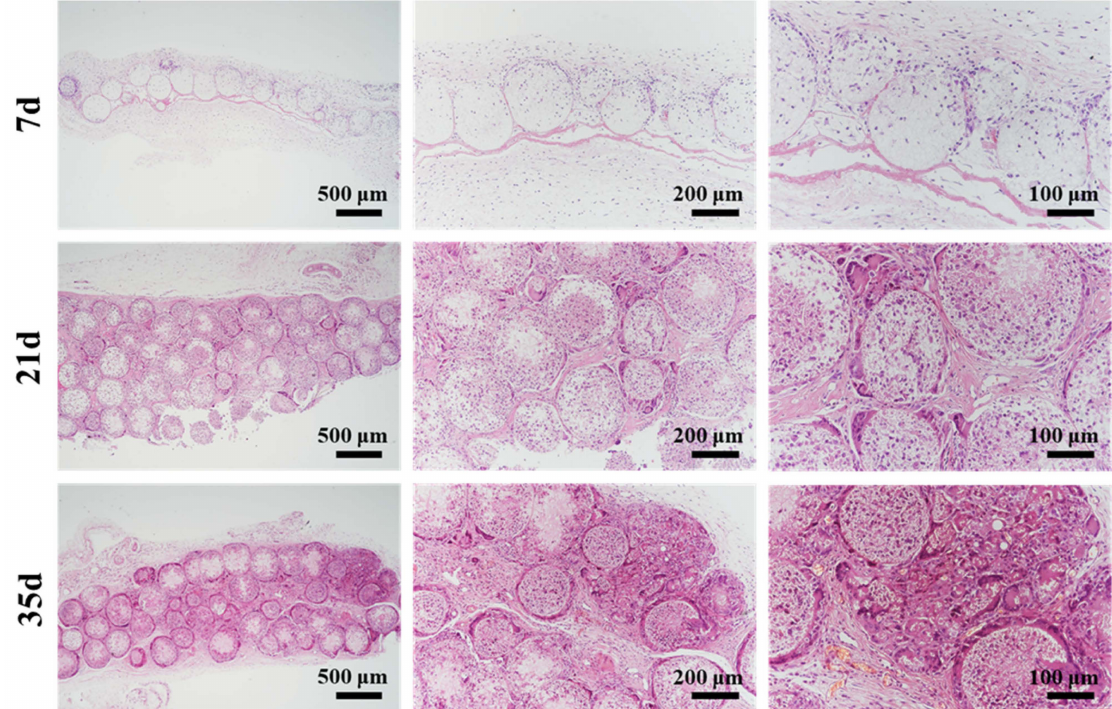
Figure 9. The results of H&E staining of implanted PDA-modified PCL porous microspheres after 7, 21, and 35